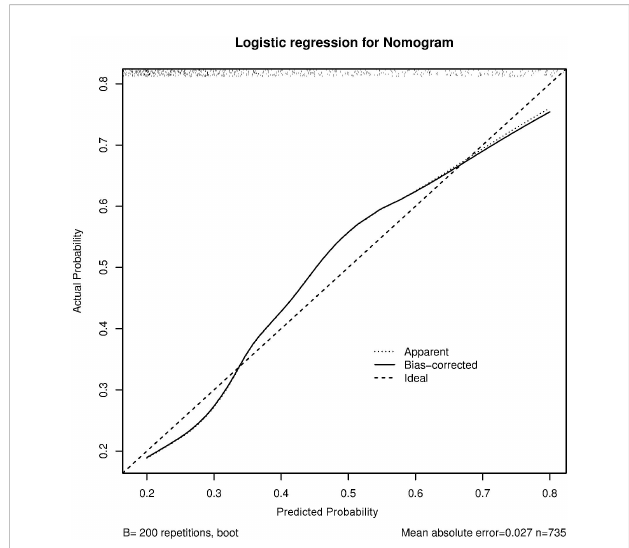
FIGURE 2 Calibration curve of non-minimal liver in fl ammation from the primary